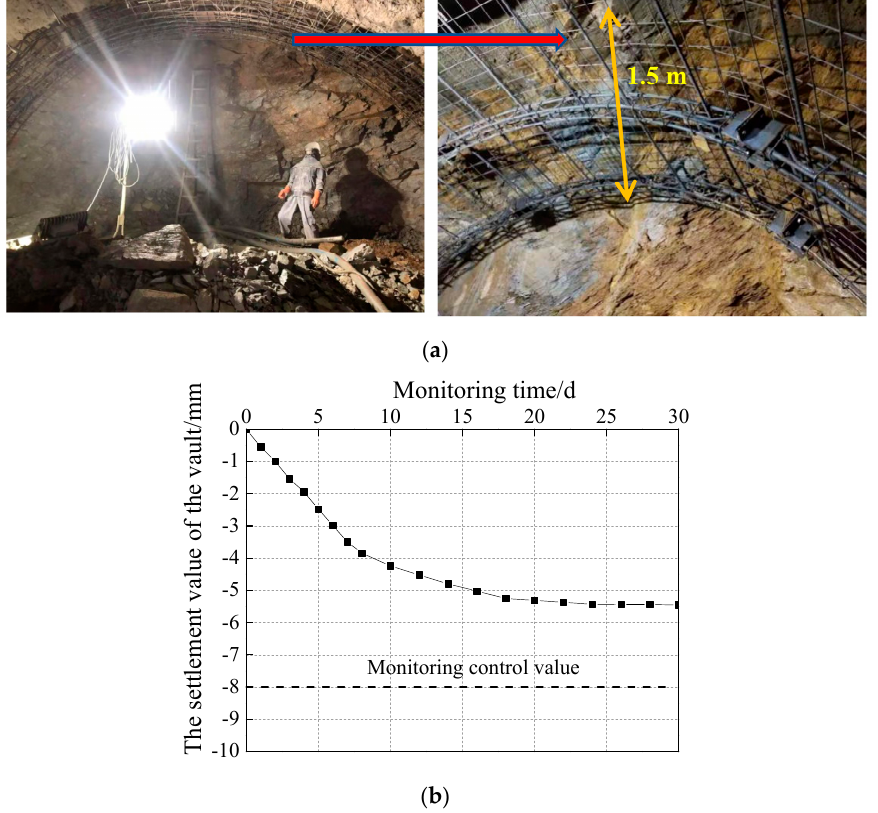
Figure 7. Optimization of tunneling excavation footage. ( a ) Optimized results of tunnel excavation at construction site. ( b ) Field monitoring data of vault settlement.